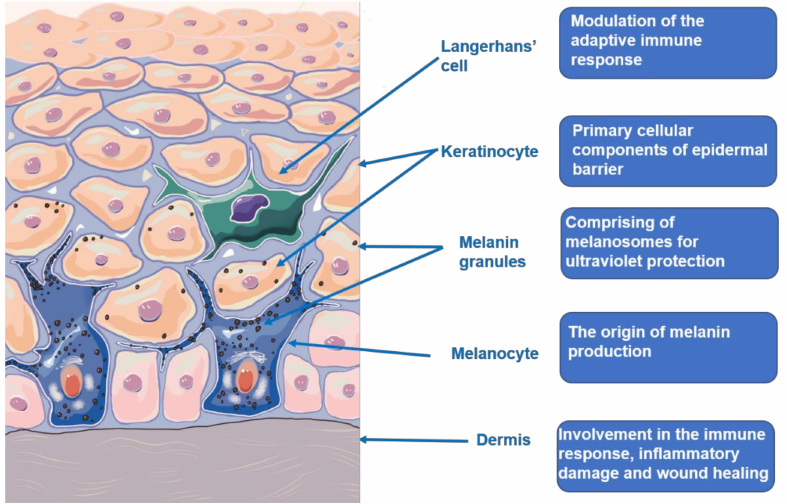
Figure 1. Skin microstructure and